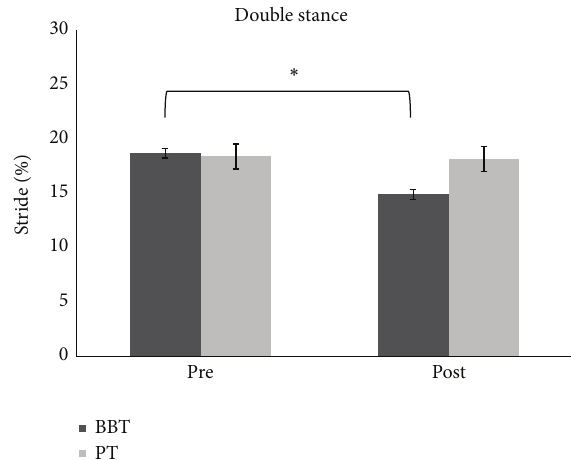
Figure 3: The graph shows the effects of BBT and PT (dark grey and light grey, resp.) on percentage of swing phase with respect to entire stride phase. Error bars indicate the standard error. PT: physical therapy; BBT: blindfolded balance training.